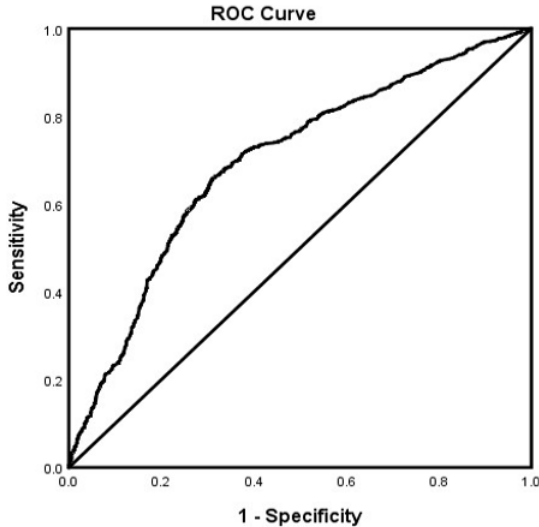
Figure 2. ROC curve associated with prediction of receiving cholinesterase inhibitor (ChEI) for late onset Alzheimer’s patients independent of gender. Higher area under the curve (AUC) values in ROC analysis indicate better discrimination of the score for the measured outcome. Classification table (overall correctly classified percentage = 67.2%) and area under the ROC curve (AUC = 0.697, 0.685–0.708) were applied to check model fitness.